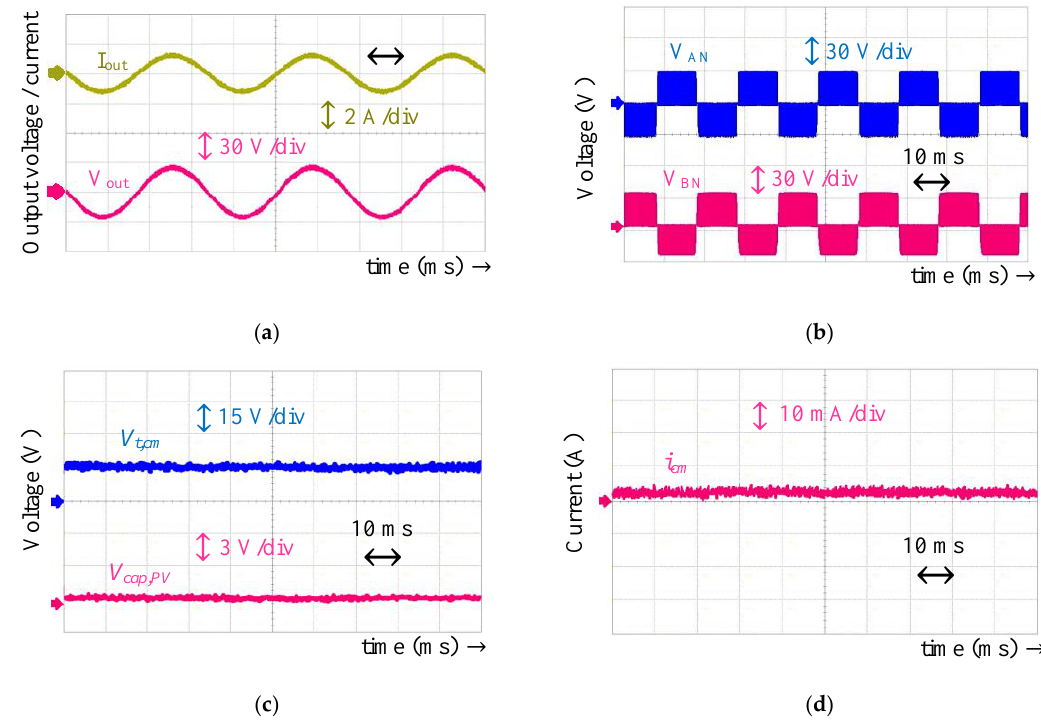
Figure 11. Experimental results; ( a ) output voltage and current; ( b ) 𝑉 𝐴𝑁 and 𝑉 𝐵𝑁 ; ( c ) 𝑉 𝑡,𝑐𝑚 ( d ) CMC.